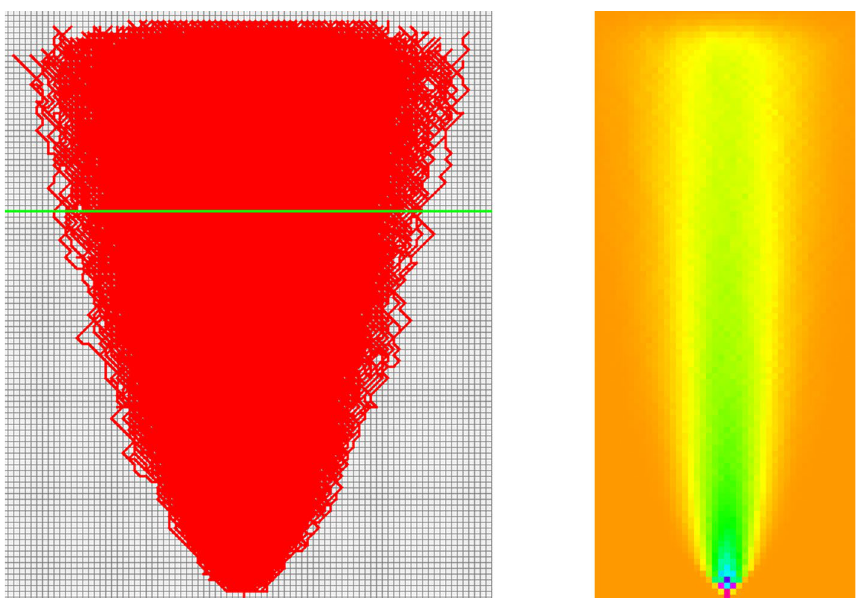
Figure 13. Random Walker #2 simulated cracks.